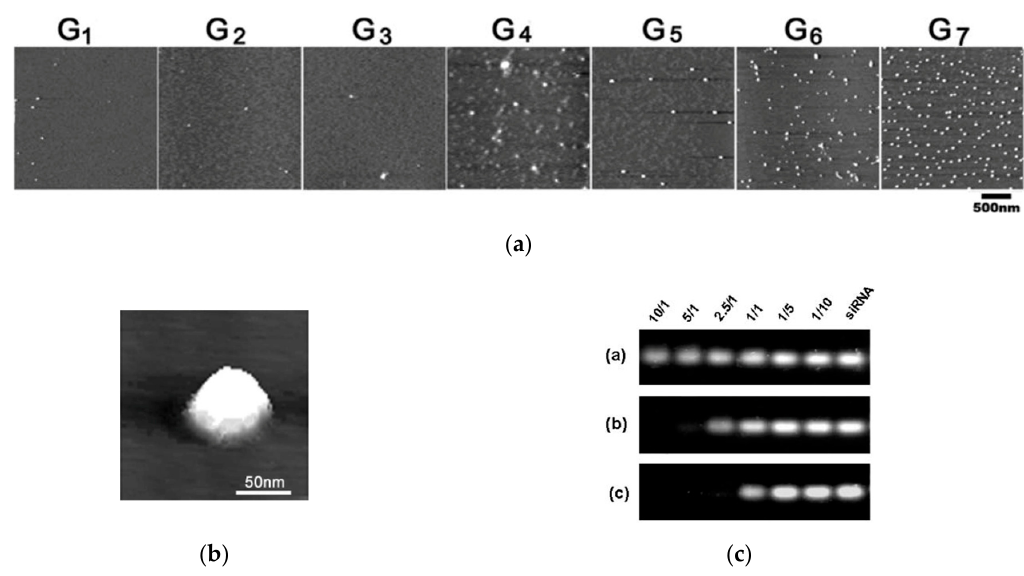
Figure 4. Three-dimensional atomic force microscopy ( AFM) images of ( a ) Hsp27 siRNA in complex with TEA-core PAMAM dendrimers of increasing generation ( G 1 – G 7 ) and ( b ) a single spherical siRNA/TEA-core dendrimer ( G 7) complex at a final siRNA concentration of 0.0125 mg/L and at a dendrimer-to-siRNA charge ratio (N/P) of 10. ( c ) Gel retardation of Hsp27 siRNA with three different TEA-core PAMAMs (( G 1 ) ( a ), ( G 4 ) ( b ) and ( G 7 ) ( c )) as a function of the N/P ratio (from 10/1 to 1/10 from left to right; last lane: Naked siRNA). Adapted from [41] with the permission of the RSC. While only a few siRNA/dendrimer assemblies can be observed for smaller dendrimers (G 1 and